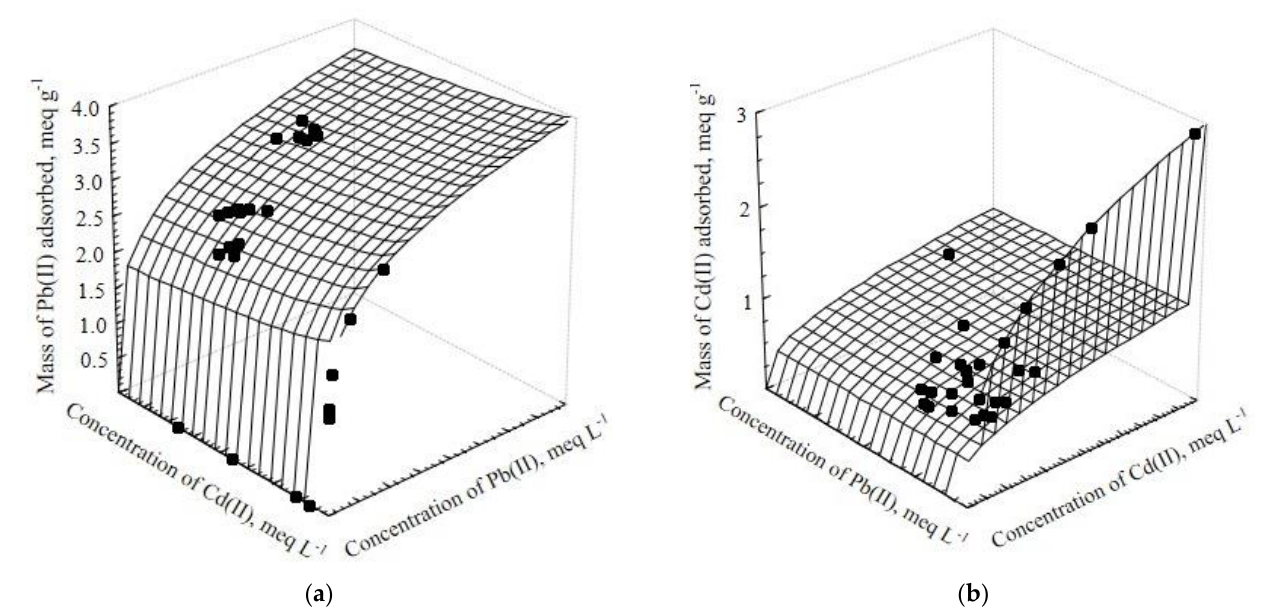
Figure 10. Multicomponent adsorption isotherms of ( a ) Cd(II) and ( b ) Pb(II) on Sargassum biomass at T = 25 °C and pH = 5.0. Adsorption surfaces are predicted with the EFMI model.